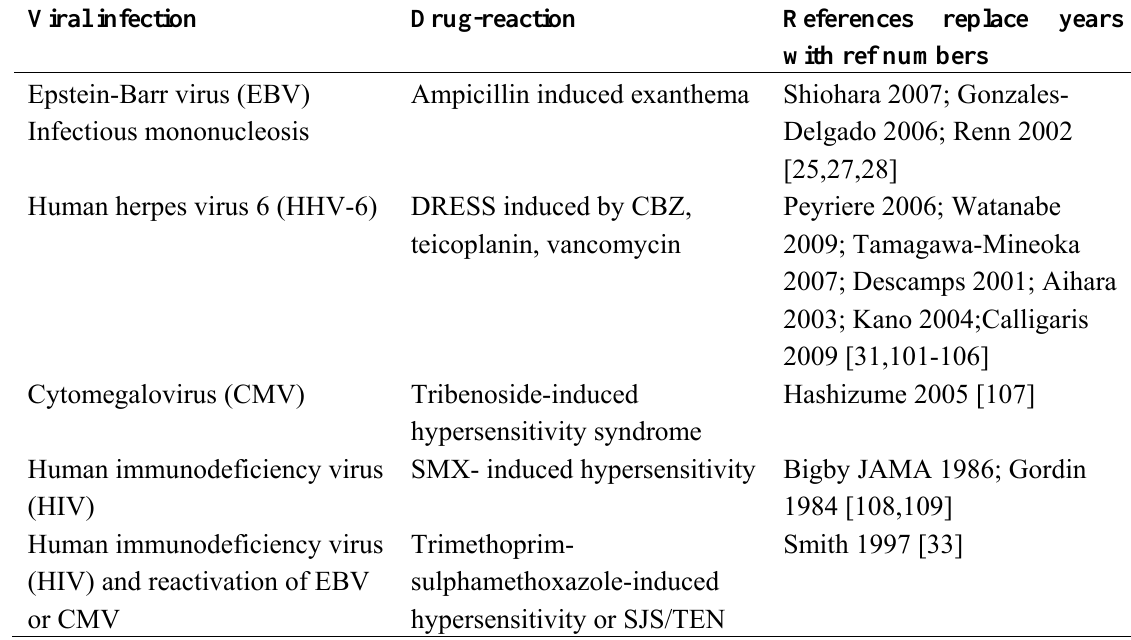
Table 2. Viral infections and drug